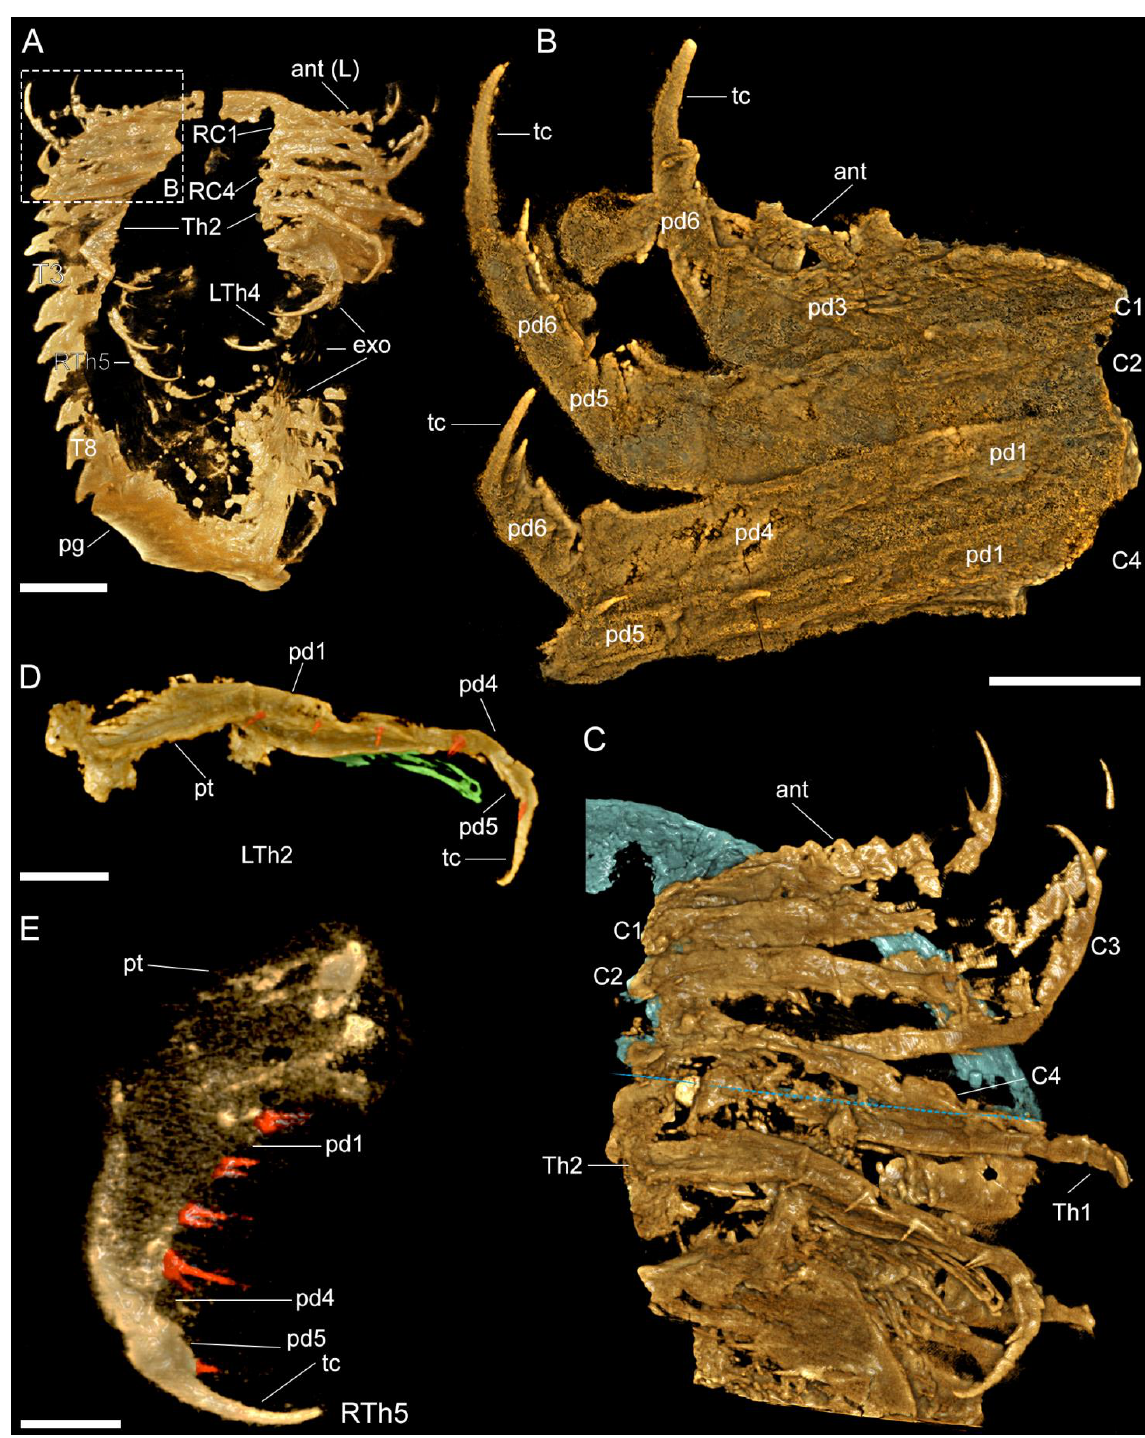
Figure 2. Images of ventral view rendered from 3D tomographic models of Retifacies abnormalis (YKLP 11430, Figure 1E). ( A ) Overview. ( B ) Close-up of right cephalic appendages (head shield removed). ( C ) Close-up of left cephalic appendages, with head shield false-coloured in blue, and the posterior edge of head shield marked with a blue – dashed line. ( D ) Close-up of second left thoracic appendage (LTh2 in ( A , C )) with exopodite false-coloured in green and enditic setae false-coloured in red. ( E ) Close up of fifth right thoracic appendage (RTh5) with enditic setae false-coloured in red. Other abbreviations; pt — protopodite. Scale bars: 1 cm in ( A ), 2 mm in ( B – D ), and 1 mm in ( E ).